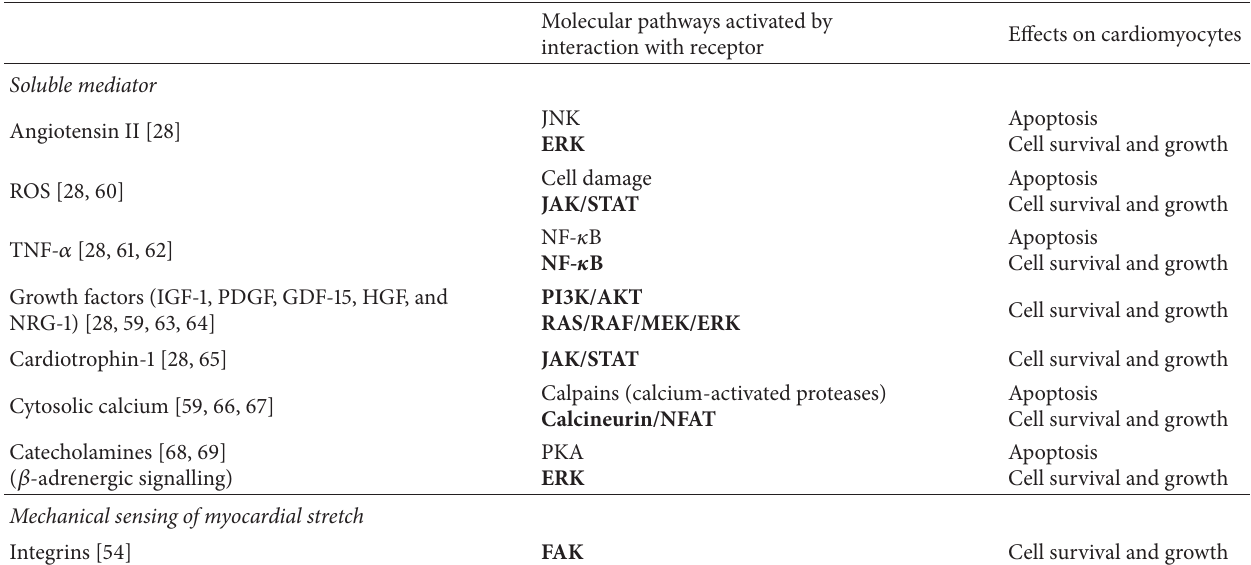
Table 1: Molecular pathways of ventricular remodelling. Many mediators have either an adaptive role (in bold) at low doses or a maladaptive role, with chronic/intense